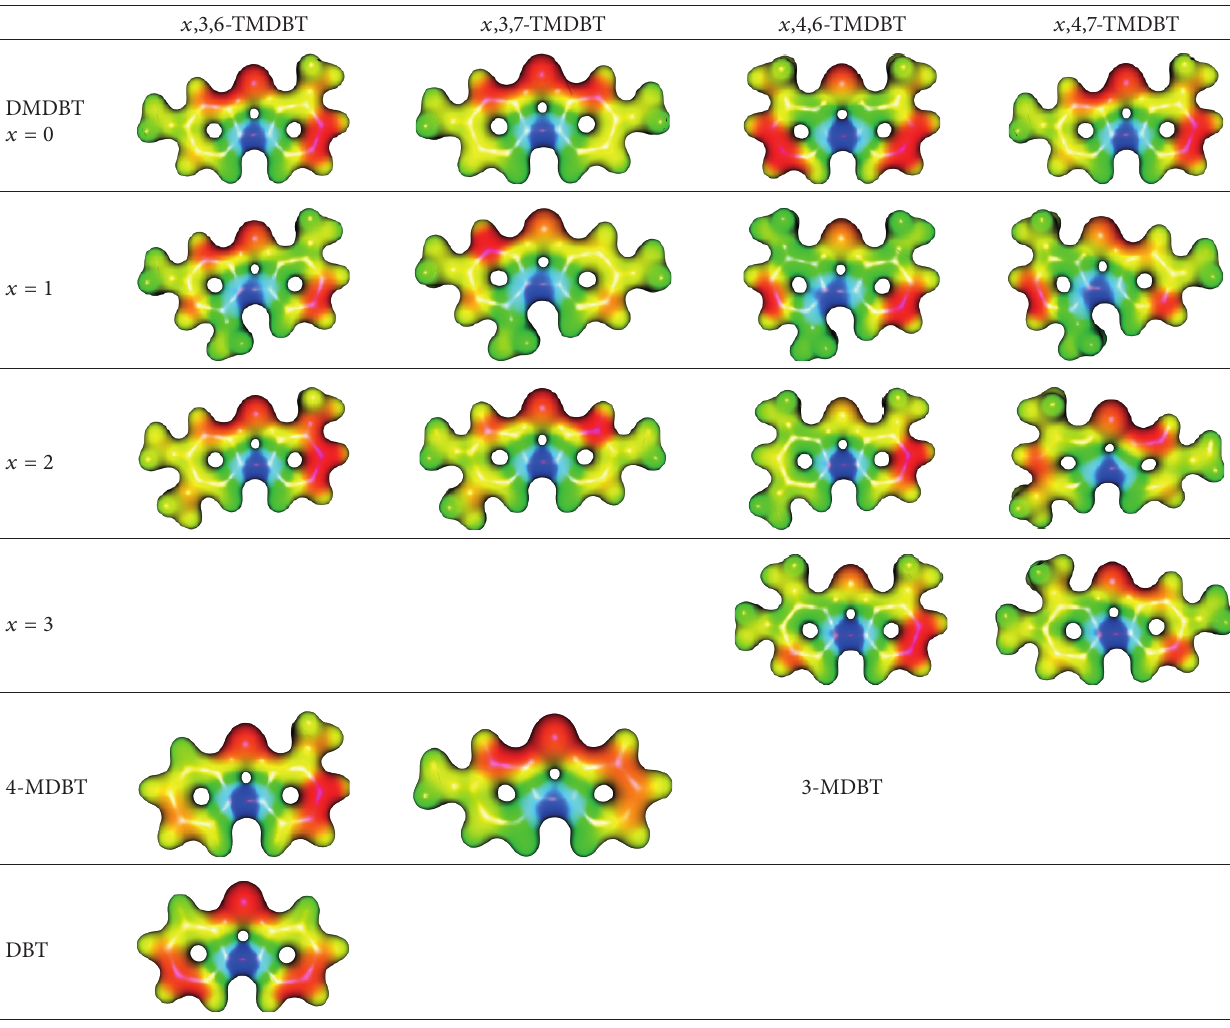
Table 3: Molecular electrostatic potential mapped at the electronic density isosurface for DBT and its methyl, dimethyl, and trimethyl derivatives. Blue areas represent regions where a proton would feel repulsion while in red areas a proton would feel attraction. DBT, 3-MDBT, and 4-MDBT are also plotted for